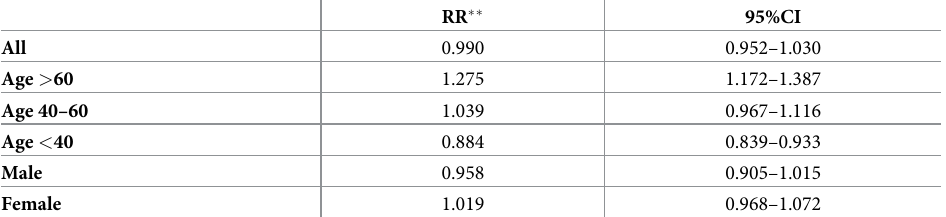
Table 2. Relative Risk (RR) for daily ED visits for headache associated with cumulative exposure over 29.5% � per- cent in two days preceding the ED